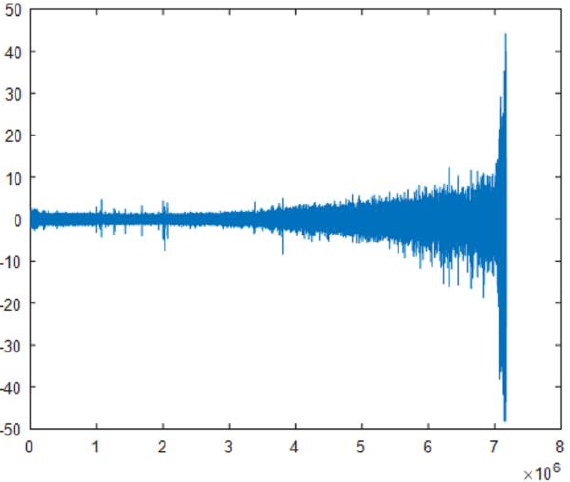
Figure 7. Time domain signal of Bearing1_1.